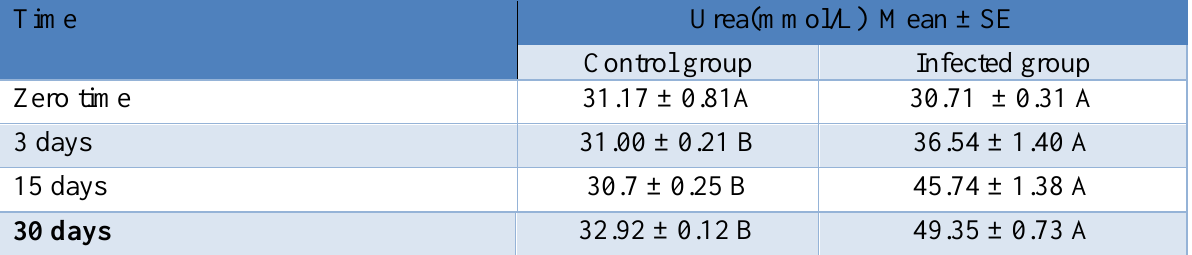
Table, 6: Effect of E.coli infection on urea value of infected group compared with control group at zero time, 3,15 and 30 days post infection.